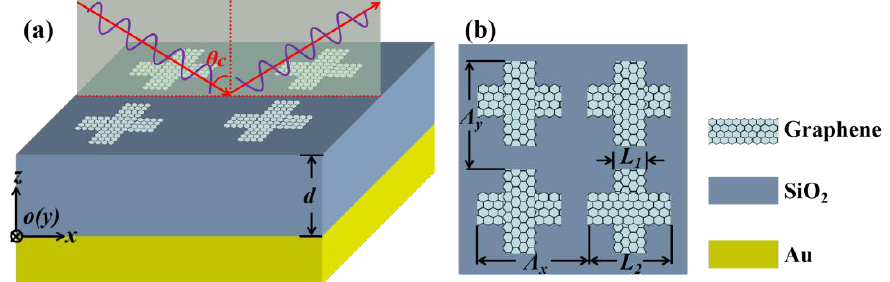
Figure 1. ( a ) Schematic diagram of the proposed absorber consisting of cross-shaped graphene arrays. From the top to the bottom are periodic cross-shaped graphene arrays, a thin SiO 2 spacer with the thickness of d , and a semi-infinite Au substrate, respectively. ( b ) Vertical view of the cross-arm of graphene with period Λ x = Λ y , width L 1 and length L 2 .